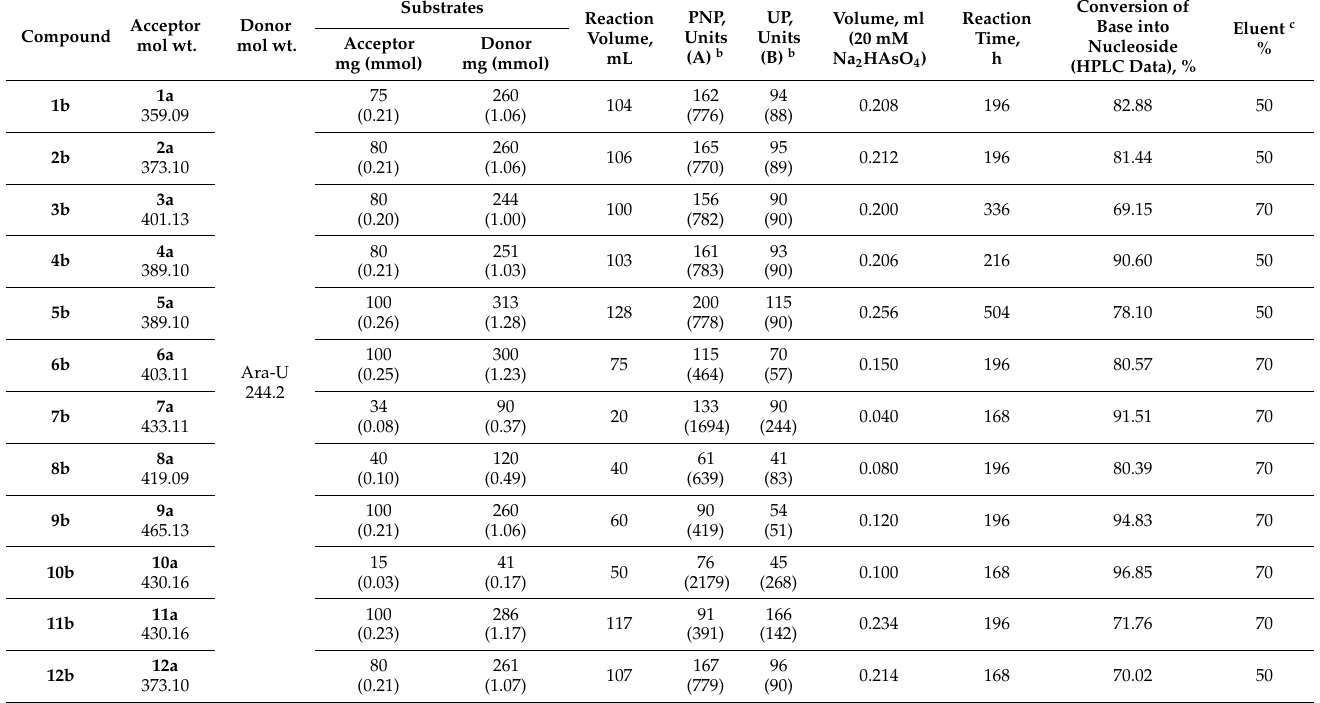
Table 3. Experimental data for the enzymatic synthesis of arabinosides 1b – 12b a . Acceptor Compound mol